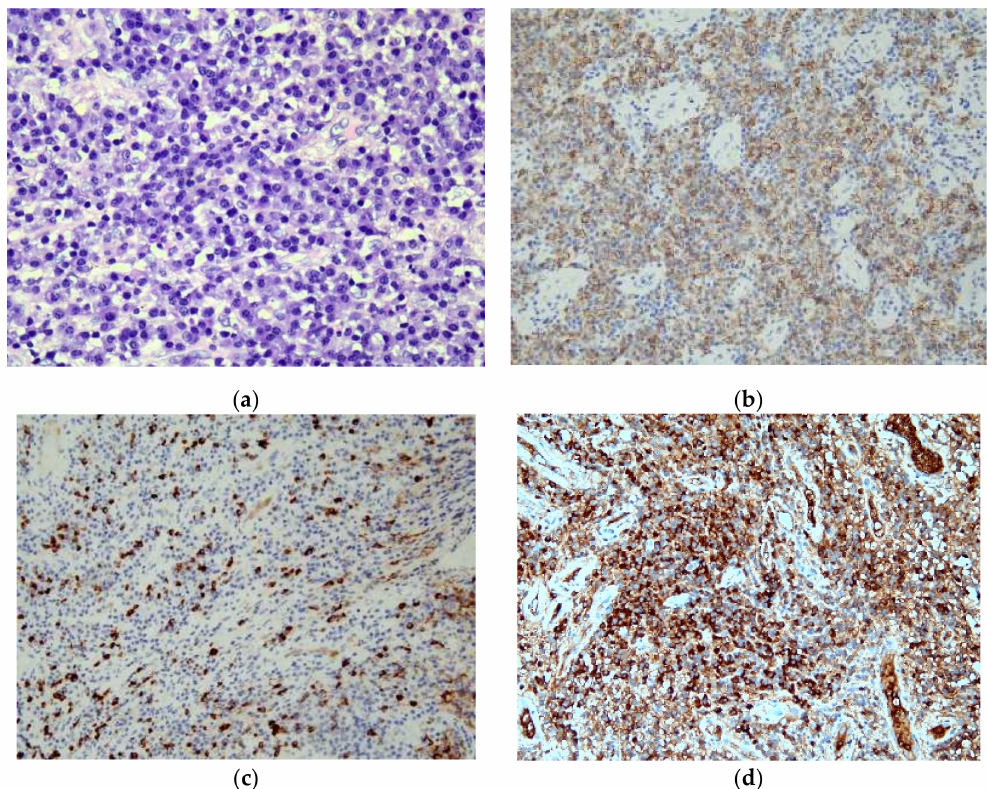
Figure 3. Microscopic evaluation of the lesion. ( a ) Lymphoplasmacytic infiltration observed using hematoxylin and eosin staining (magnification, 200 × ). ( b ) Immunohistochemistry (IHC) results for CD138 showing positivity for plasma cells (magnification, 100 × ). ( c ) IHC staining for IgG4 showing positivity for plasma cells (magnification, 100 × ). ( d ) IHC staining for IgG showing positivity for plasma cells (magnification, 100 ×